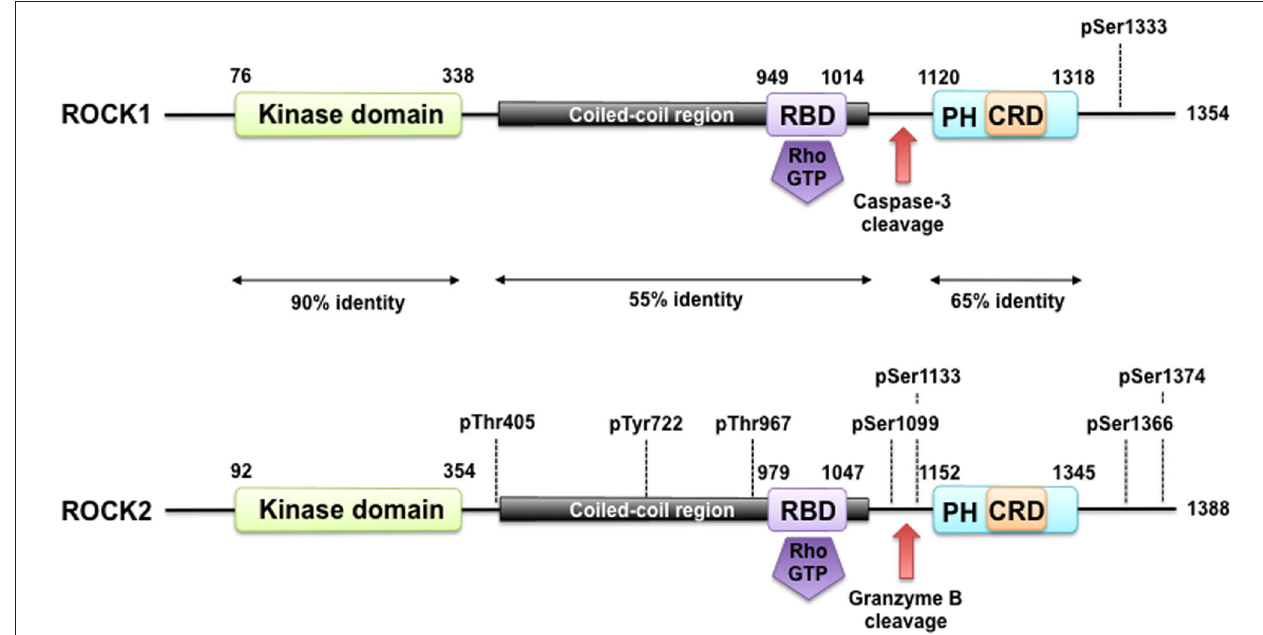
FIGURE 1 | ROCK structure and modes of regulation. ROCK1 and ROCK2 consist of an N-terminally located kinase domain and a C-terminally located pleckstrin homology (PH) domain containing a cysteine-rich C1 domain (CRD). The region between the ROCK kinase domain and the PH domain forms a coiled coil structure, in which the Rho binding domain (RBD) is located. Both are highly homologous and share overall 64% amino acid sequence identity. A splice variant of ROCK2 contains an insertion of 57 amino acids following the RBD and is called ROCK2m. ROCK1 and ROCK2 can be activated by binding of RhoGTP to the RBD and through cleavage of ROCK1 by caspase-3 and of ROCK2 by granzyme B and caspase-2. Autophosphorylation of ROCK1 at Ser1333 and of ROCK2 at Ser1366 reflects the activation status of the kinases. Phosphorylation of ROCK2 at Thr967, Ser1099, Ser1133, or Ser1374 increased its activation status, whereas phosphorylation of Tyr722 decreases the ability of ROCK2 to bind to RhoA. Interaction of Thr405 of ROCK2 with the N-terminal extension of the ROCK2’s kinase domain is essential for substrate phosphorylation and kinase domain